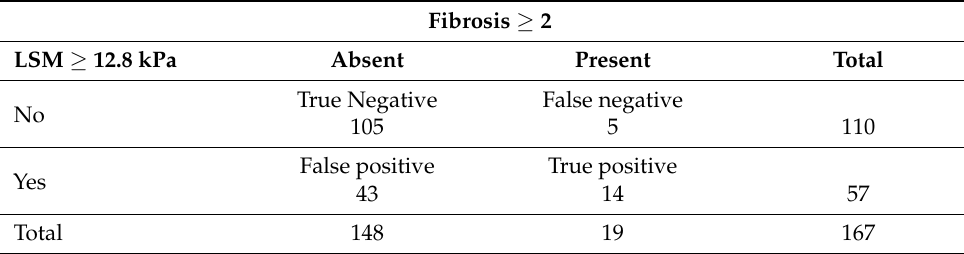
Table 4. Classification of the enrollee subjects who underwent bariatric surgery according to the presence of significant fibrosis (F ≥ 2) and LSM ≥ 12.8 kPa.